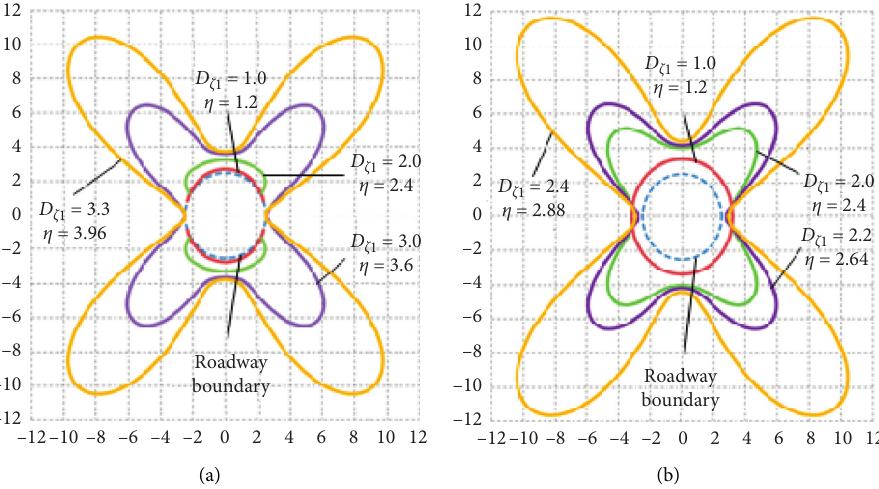
Figure 4: Morphology distribution of the roadway plastic zone influenced by the maximum principal stress.